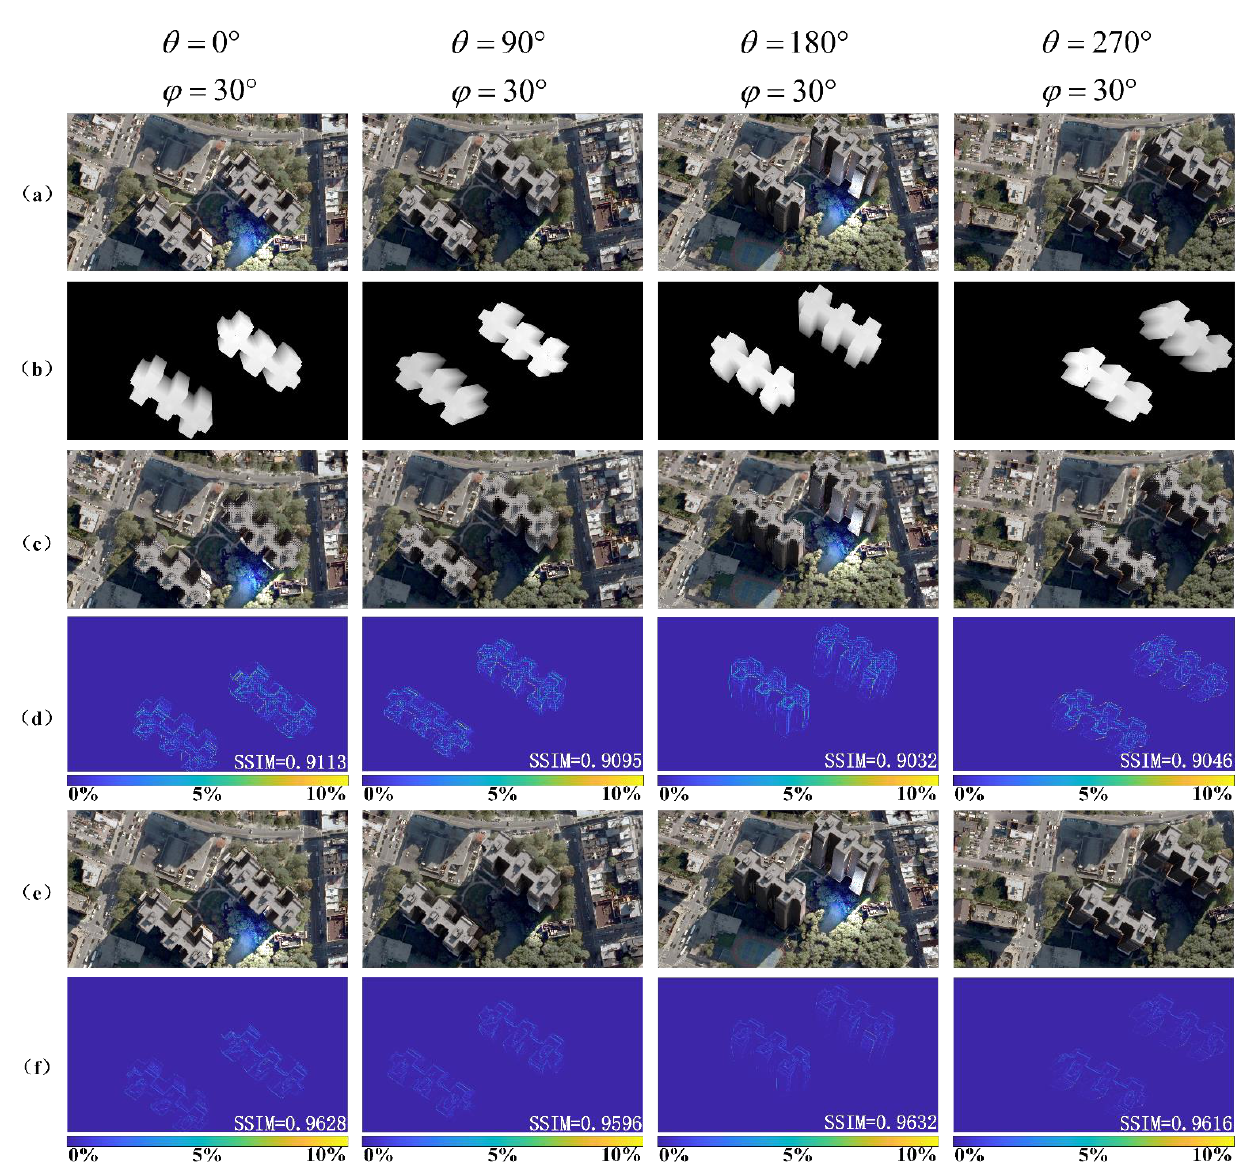
Figure 5. Simulation results: ( a ) Perspectives captured from different angles; ( b ) depth maps of different perspectives; ( c ) simulation results of the reconstructed image without optimized algorithm; ( d ) the SSIM values without optimized algorithm; ( e ) simulation results of the reconstructed image with proposed optimized algorithm; ( f ) the corresponding SSIM values with proposed optimized algorithm.